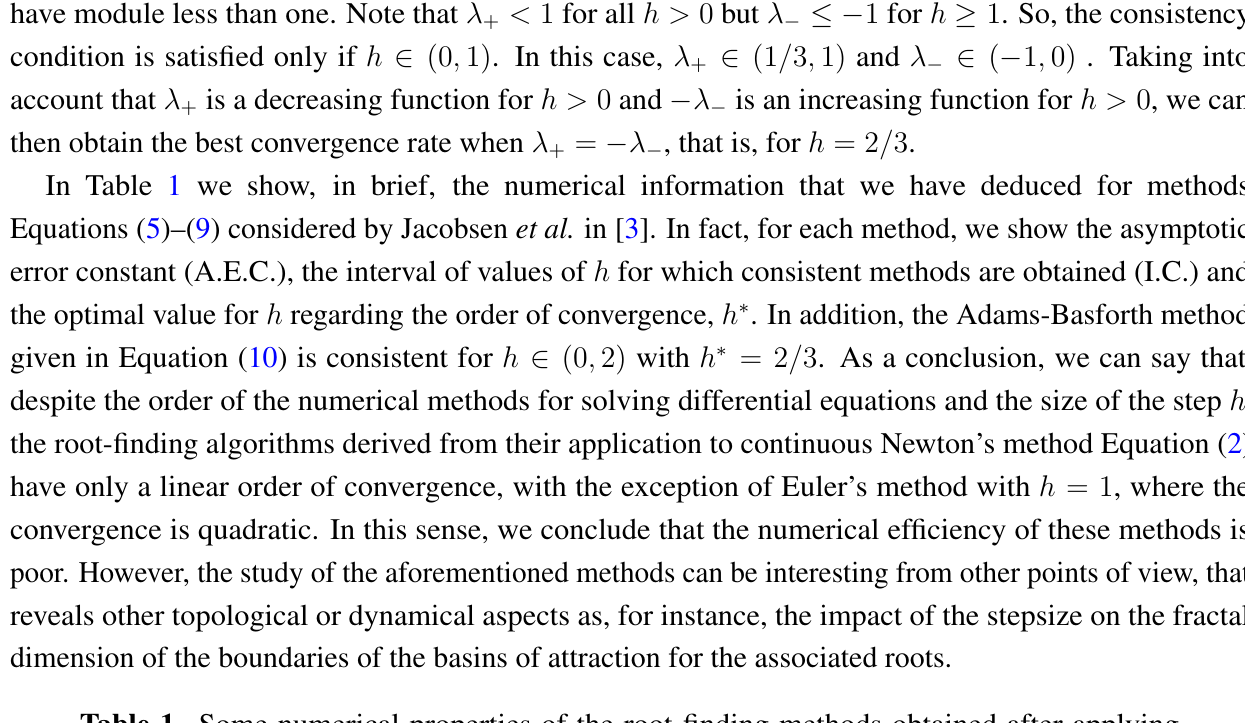
Table 1. Some numerical properties of the root-finding methods obtained after applying methods Equations (5)–(9) to continuous Newton’s method Equation